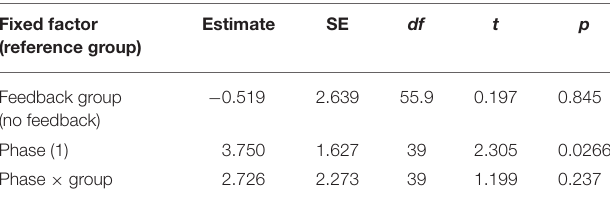
TABLE 6 | LME results by feedback group and by experiment